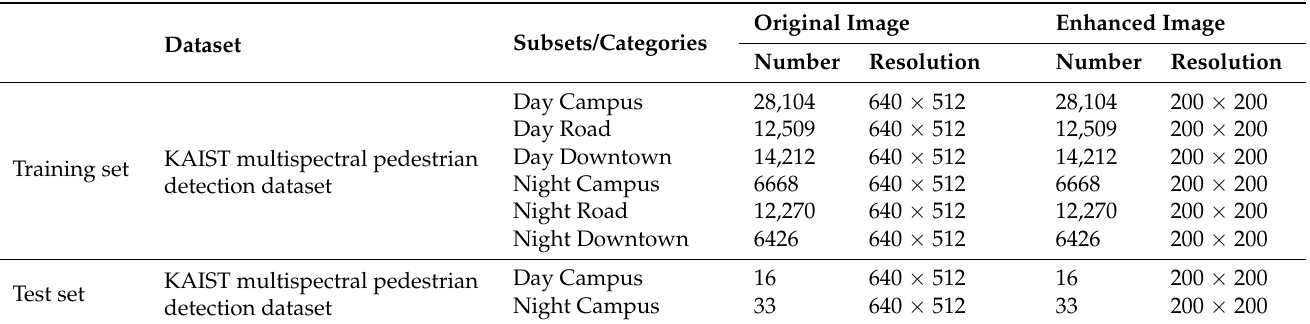
Table 3. Comparison information of the original dataset and the enhanced real dataset. The source image column indicates the number and resolution of images used in different subsets or categories in the source dataset (KAIST multispectral pedestrian detection dataset). The enhanced image column indicates the number and resolution of images in different subsets or categories in the real dataset after